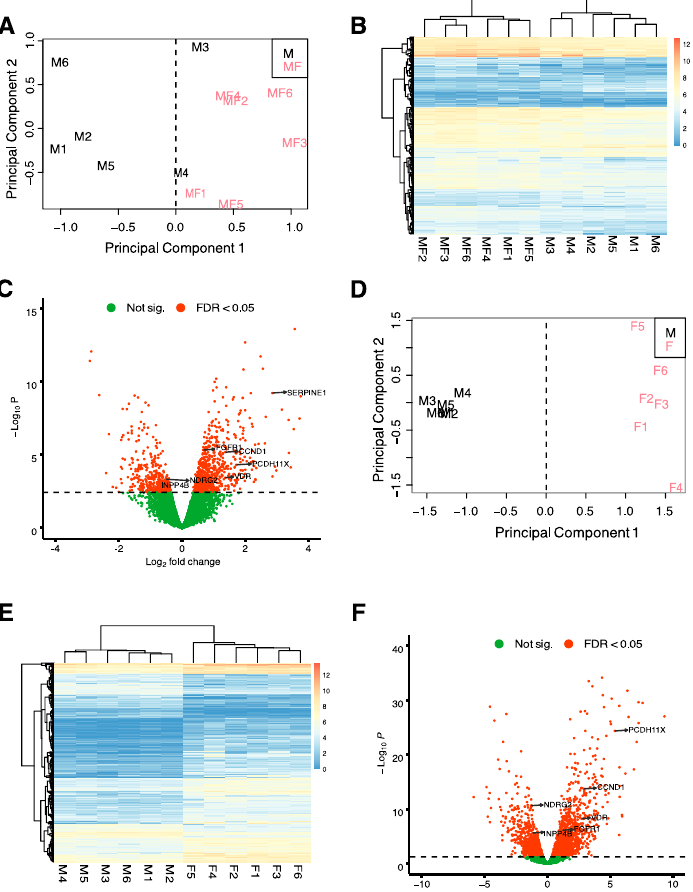
Figure 1. Comparison of transcriptome profiles of myometrial samples from non-fibroid patients (M) with myometrial (MF) and fibroid (F) samples from fibroid patients. ( A ) Multidimension scaling (MDS) plot of RNA-seq results from non-fibroid myometrial samples compared with samples from fibroid-bearing myometria. Each label represents one sample. Myometrial samples from non-fibroid patients (M) are shown with black letters ( n = 6) and myometrial samples from fibroid patients (MF) are shown with red letters ( n = 6). ( B ) Heatmap of the top 500 differentially expressed genes (DEGs) from the MF vs. M comparison with unsupervised hierarchical clustering of genes and samples ( n = 6/group). ( C ) Volcano plot showing up ( n = 705) and downregulated genes ( n = 464) with a false discovery rate (FDR) p -value < 0.05 in MF vs. M depicted as red dots. ( D ) MDS plot of RNA-seq results from non-fibroid myometrial samples compared with fibroid samples. Each label represents one sample. Myometrial samples from non-fibroid patients (M) are shown with black letters ( n = 6) and fibroid samples (F) are shown with red letters ( n = 6). ( E ) Heatmap of the top 500 DEGs from the M vs. F comparison with unsupervised hierarchical clustering of genes and samples ( n = 6/group). ( F ) Volcano plot showing up ( n = 1736) and downregulated genes ( n = 1323) with FDR p -value < 0.05 in M vs. F depicted as red dots. Color gradient represents gene expression as log 2 (CPM + 1) in B and